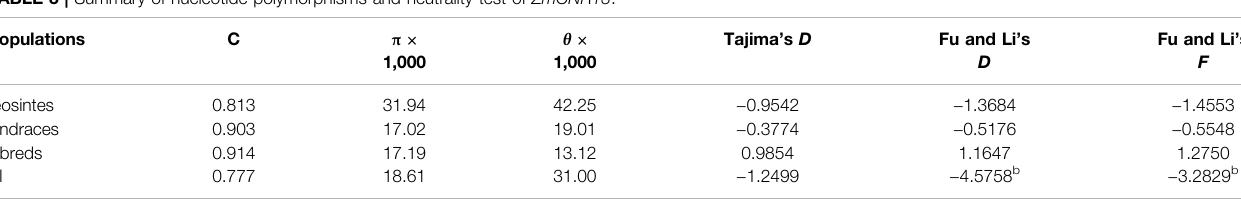
TABLE 3 | Summary of nucleotide polymorphisms and neutrality test of ZmCNR13 .